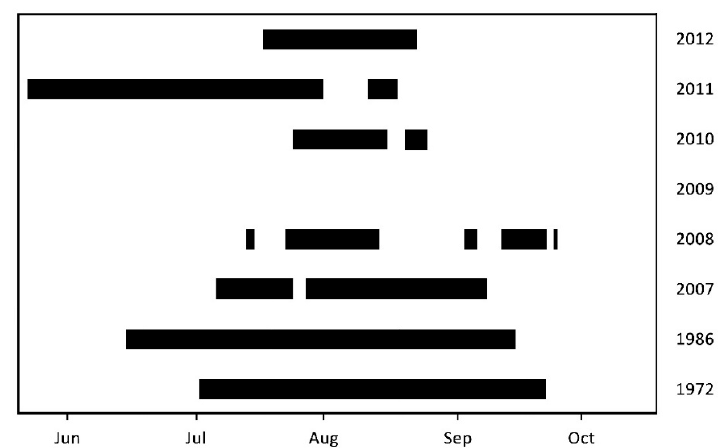
Figure 3. The duration of suspended sediment concentration (SSC) monitoring in Breelva. The days of sampling (2 or 3 samples a day) in each year (1972, 1986, 2007, 2008, 2010, 2011, 2012).